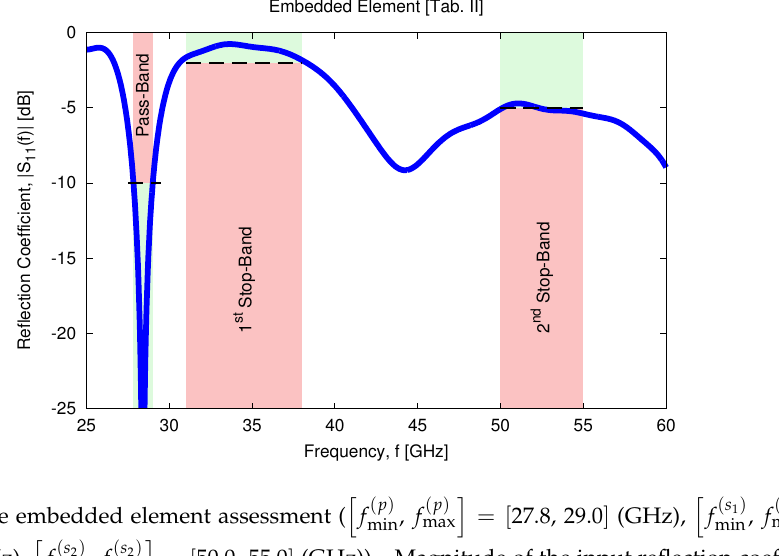
(cid:104) (cid:105) ( s 2 ) ( s 2 ) = [ 50.0, 55.0 ] (GHz))—Magnitude of the input reflection coefficient, f , f max min